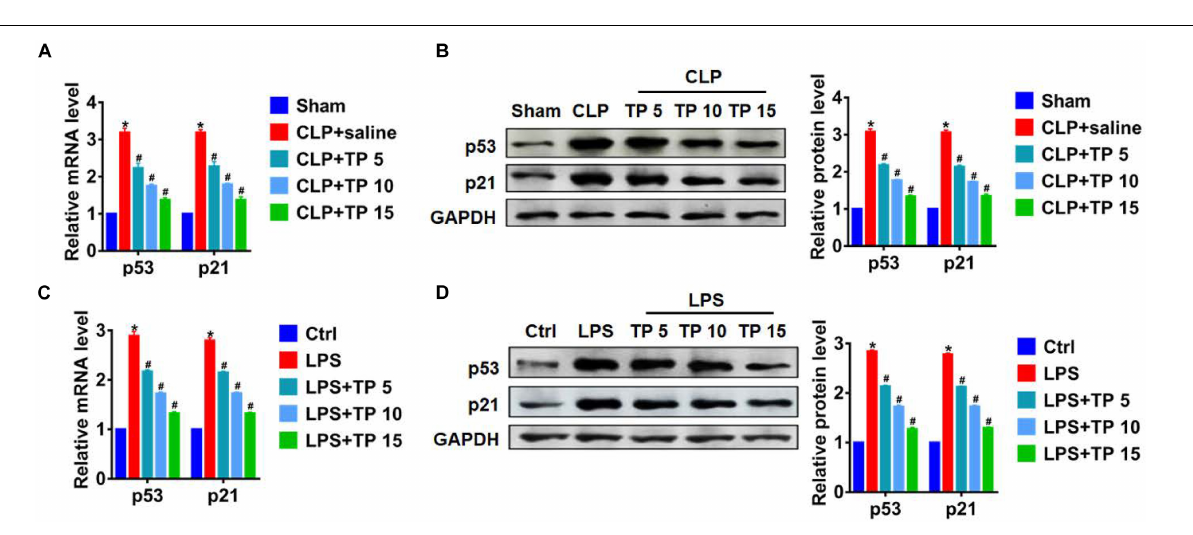
FIGURE 3 | TP inhibited senescence during lung injury. (A) qRT-PCR of the mRNA expression of p53 and p21 in lungs from rats. n = 5, * P < 0.05 vs. Sham, # P < 0.05 vs. CLP. (B) Western blot analysis of p53 and p21 protein expression in lungs from rats. n = 5, * P < 0.05 vs. Sham, # P < 0.05 vs. CLP. (C) qRT-PCR for mRNA expression of p53 and p21 in L2 cells. n = 5, * P < 0.05 vs. control, # P < 0.05 vs. LPS. (D) Western blot analysis for p53 and p21 protein expression in L2 cells. n = 5, * P < 0.05 vs. control, # P < 0.05 vs.